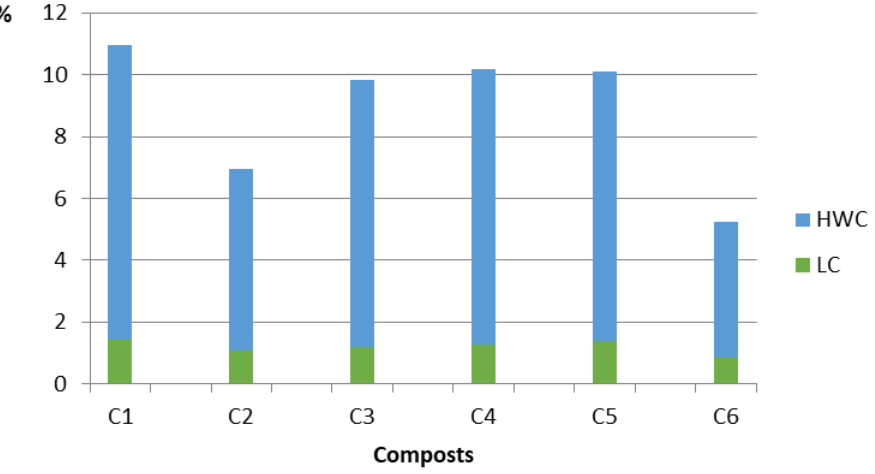
Figure 1. Percentage shares of different fractions of carbon (LC—labile carbon, HWC—hot water- extractable organic carbon) in its total content.